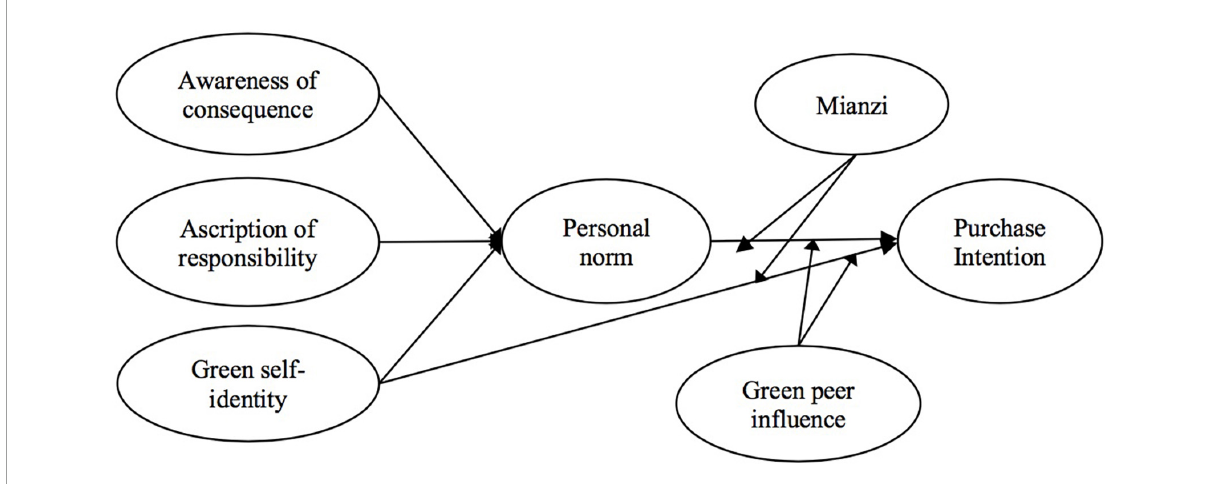
FIGURE1 Research